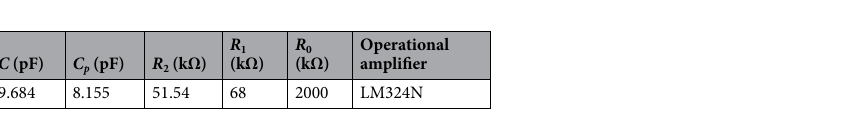
Table 3. The parameters of the negative capacitance